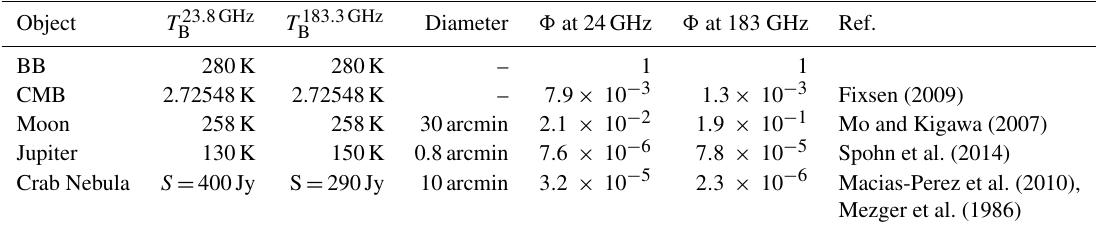
Table 5. Brightness of different astronomical sources. No brightness temperatures are given for the Crab Nebula, for this is not thermal emission. The flux densities (cid:56) in the fifth and sixth column are normalised to the black body. The values were calculated for two channels with very different frequencies on AMSU-A and MHS; the exposures of DSV and black body differ typically by 3500 counts for channel 1 of AMSU-A and 47000 counts for channel 3 of